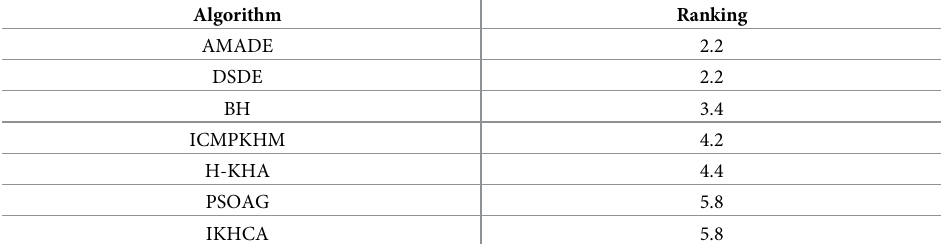
Table 10. Friedman tests based on the average of the intra-clusters distances. Algorithm